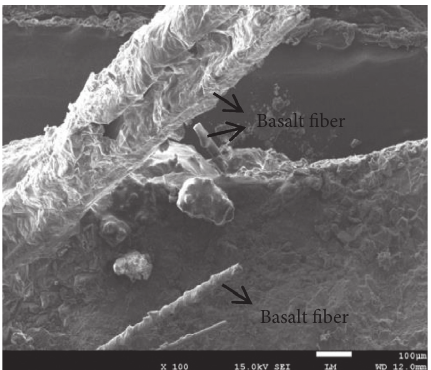
Figure 14: The bonding interface between basalt fibers and bitumen.